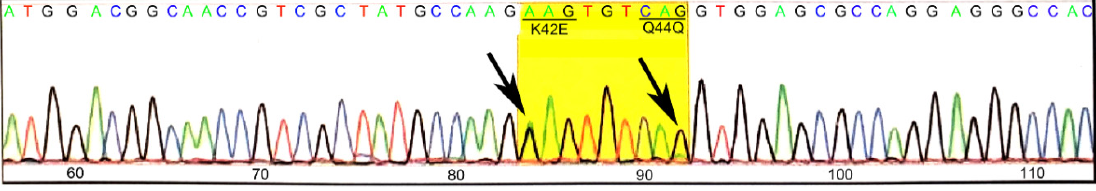
Figure 1. DNA sequence analysis of a tail DNA from a K42E/+ founder mouse. Tail DNA was amplified with primers that cover a 292 bp segment spanning the target region. The sequence analysis confirmed the presence (arrows) of the K42E (A-to-G) mutation and the Q44Q (G-to-A) polymorphism that was included to eliminate the CRISPR-related PAM site.